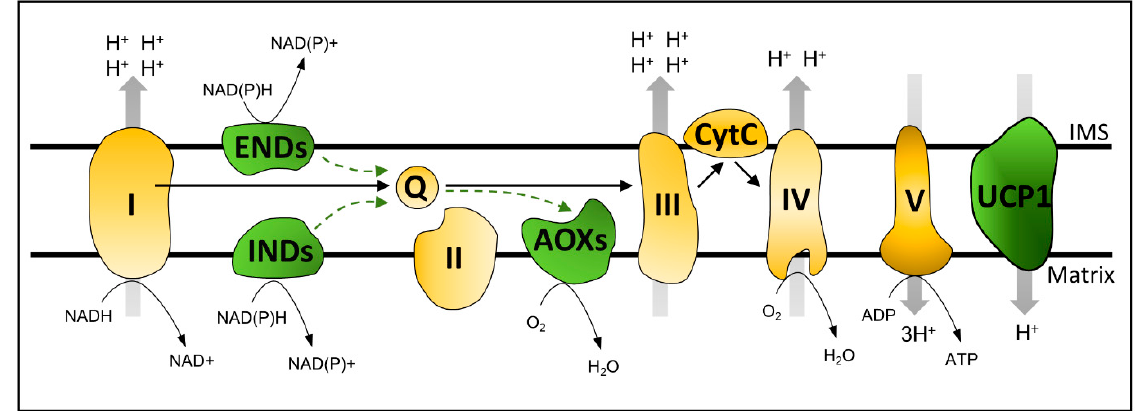
Figure 1. Plant mitochondrial oxidative phosphorylation (OXPHOS). Schematic representation of the canonical mitochondrial oxidative phosphorylation machinery (yellow) composed of the four multi-subunit complexes of the mitochondrial electron transport chain (Complex I–IV) and two intermediary substrates, namely, ubiquinone (Q) and cytochrome c (CytC). These components generate an electrochemical gradient between the mitochondrial inner membrane space (IMS) and the matrix. Protons flow back to the matrix via Complex V to produce ATP. Bypasses of the canonical OXPHOS (green) include INTERNAL (INDs) and EXTERNAL (ENDs) NAD(P)H DEHYDROGENASES, ALTERNATIVE OXIDASES (AOXs), and UNCOUPLING PROTEINS (UCPs). Protein sizes are not scaled.